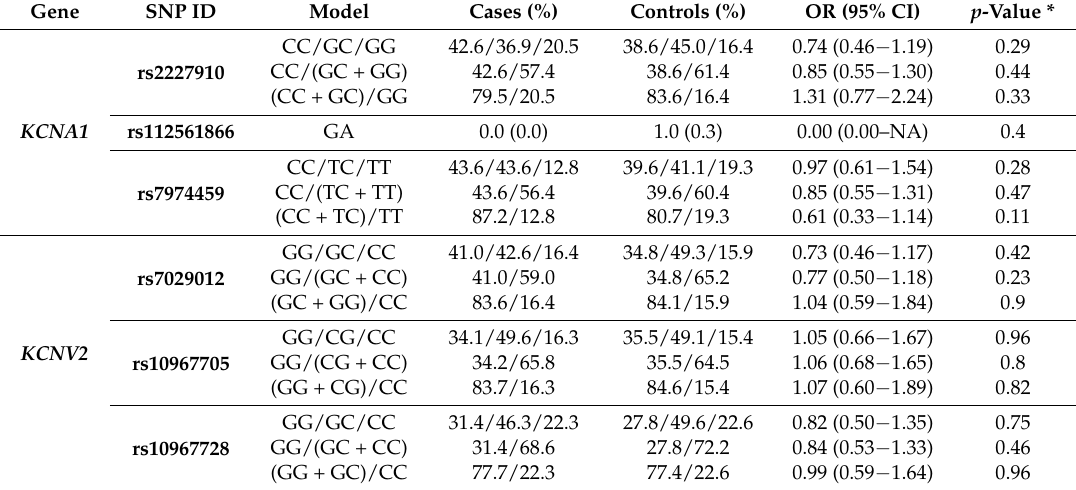
Table 4. Distribution of potassium channel related SNPs in the 124 partial epileptic patients and 299 healthy controls.